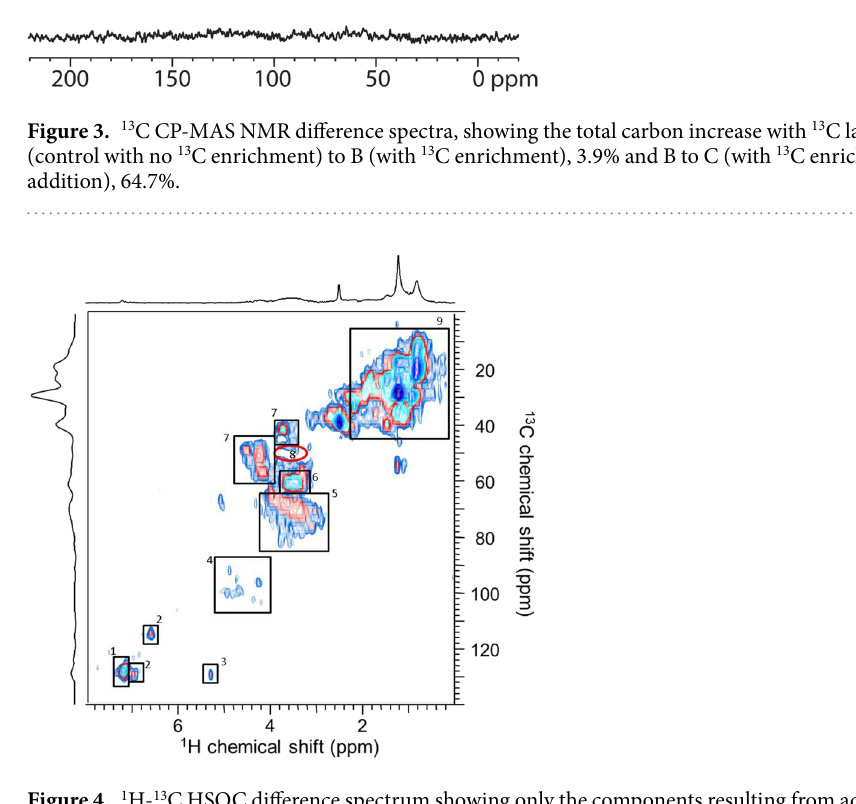
Figure 4. 1 H- 13 C HSQC difference spectrum showing only the components resulting from addition of sulfur in the DMSO swellable fraction. Assignments in 1, phenylalanine (from peptide/protein); 2, tyrosine (from peptide/protein); 3, unsaturations (HC = CH) in lipids, 4, anomeric protons (carbohydrates); 5, other CH in carbohydrates; 6, CH 2 in carbohydrates; 7, α -protons in peptides and proteins; 8, methoxyl in lignin; 9, aliphatic linkages including signals from various lipids, and side chain protons in